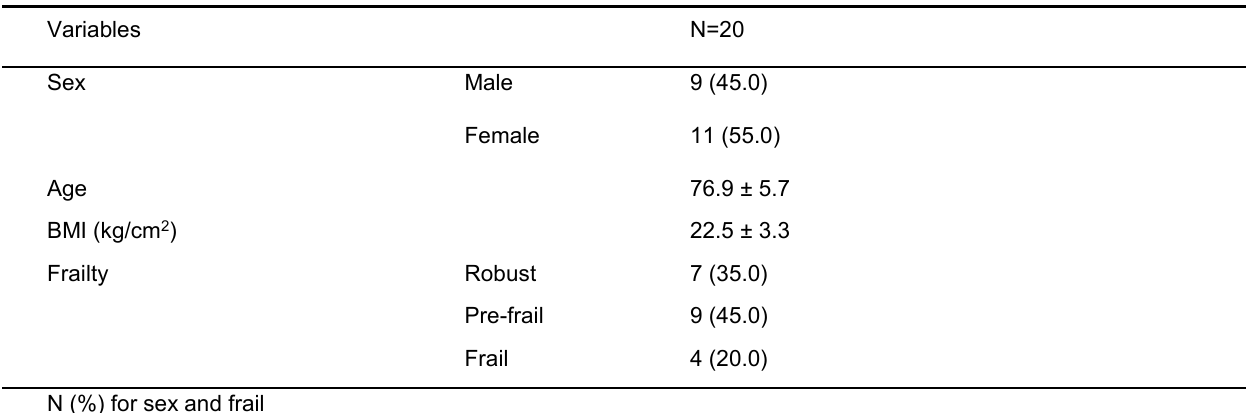
Participant Characteristics